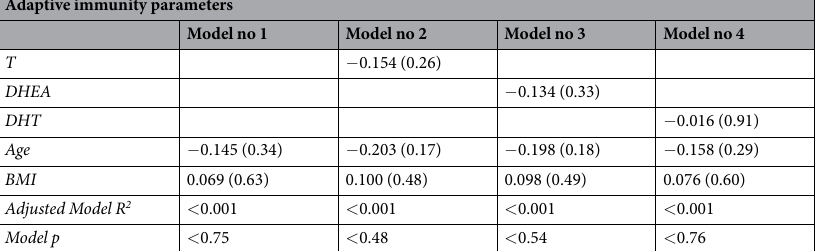
Table 4. Multiple regression models showing the relationship between each androgen and adaptive immune parameters (a–g), when participants’ age and body mass index (BMI) were controlled. Entries are standardized beta coefficients with p values in